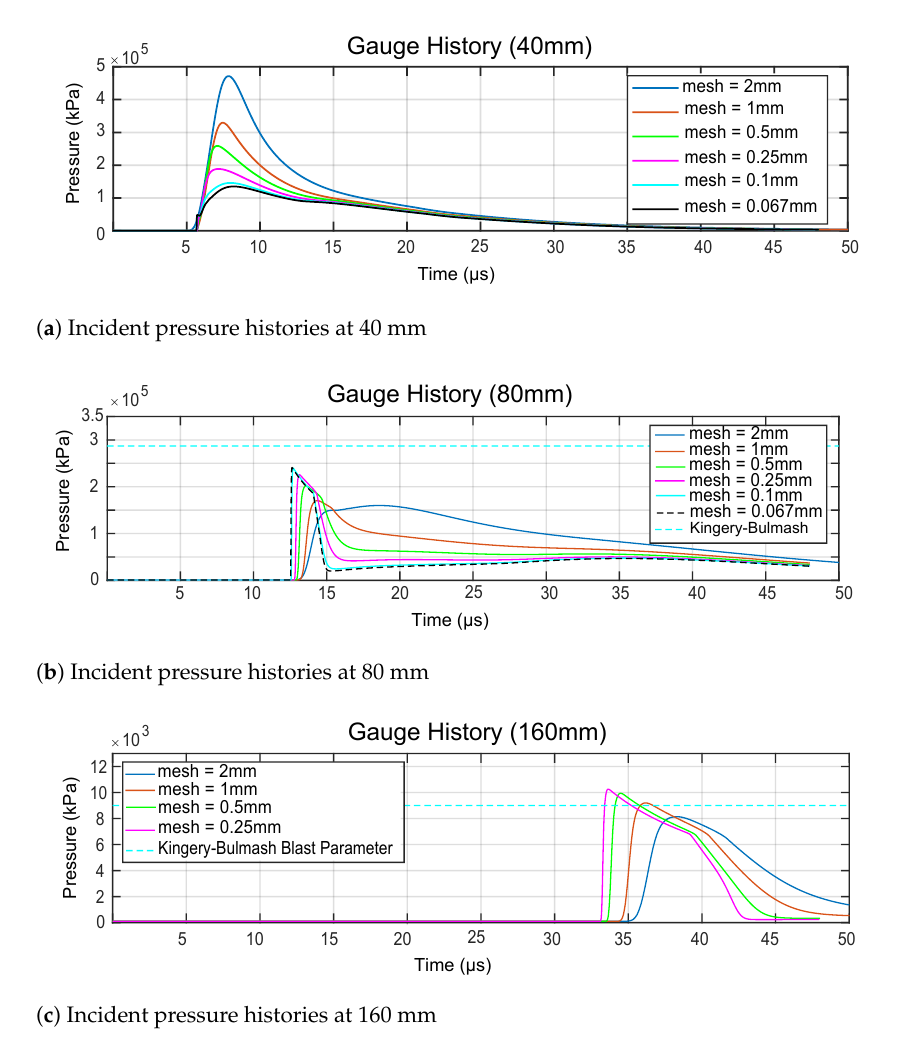
Figure 6. Near-field incident pressure histories for a spherical charge of 225 g of